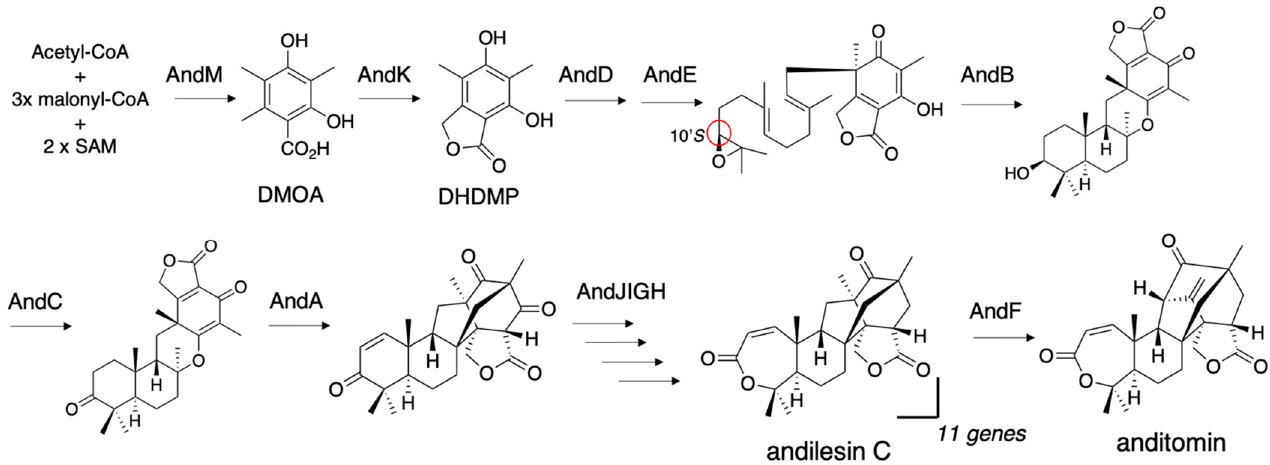
Figure 5. The 11-step anditomin biosynthetic pathway reconstructed in the A. oryzae heterologous expression system and the AndF reaction. C-10’ S is highlighted with a red circle.